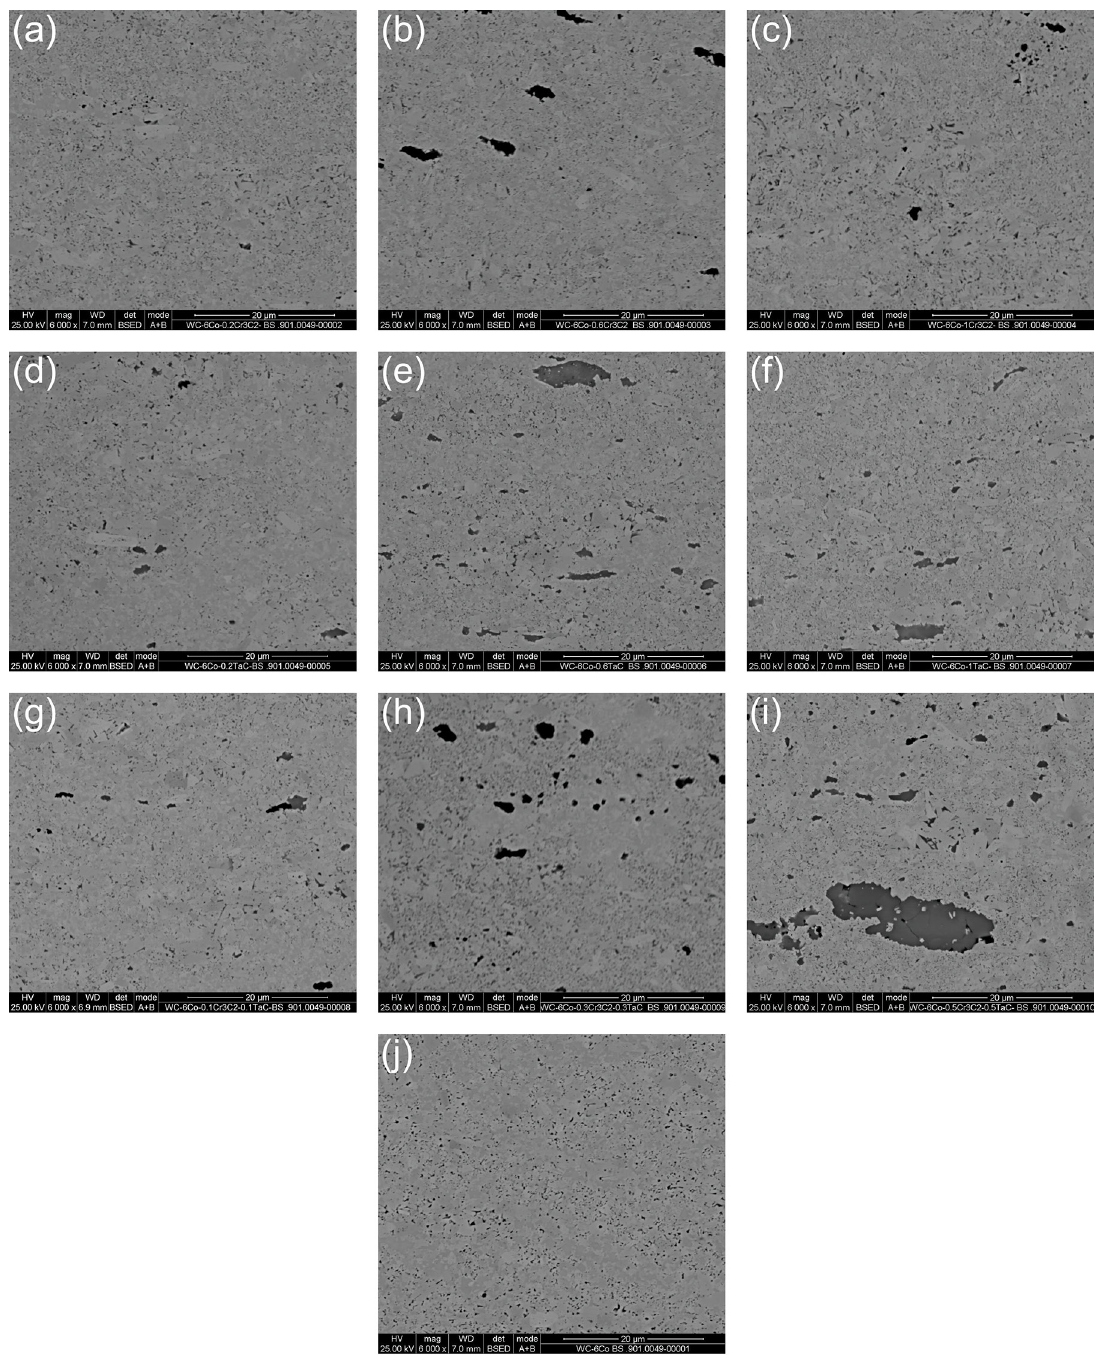
C (a) x = 0.2, (b) x = 0.6, (c) x = 1.0 and WC-6Co- 3 2 C -xTaC (g) x = 0.1, (h) x = 0.3, (i) x = 0.5 and (j) WC-6Co cemented carbides. 3 3 an influence not only on an increase in hardness but also on . The hardness obtained in this an increase in fracture toughness. The specimen with the 30 highest content of Cr C (1 wt%) is characterized by the 3 2 highest hardness of 1936 HV and fracture toughness of 30 C has 10.38 MPa·m 1/2 of the obtained materials. In turn, the 3 2